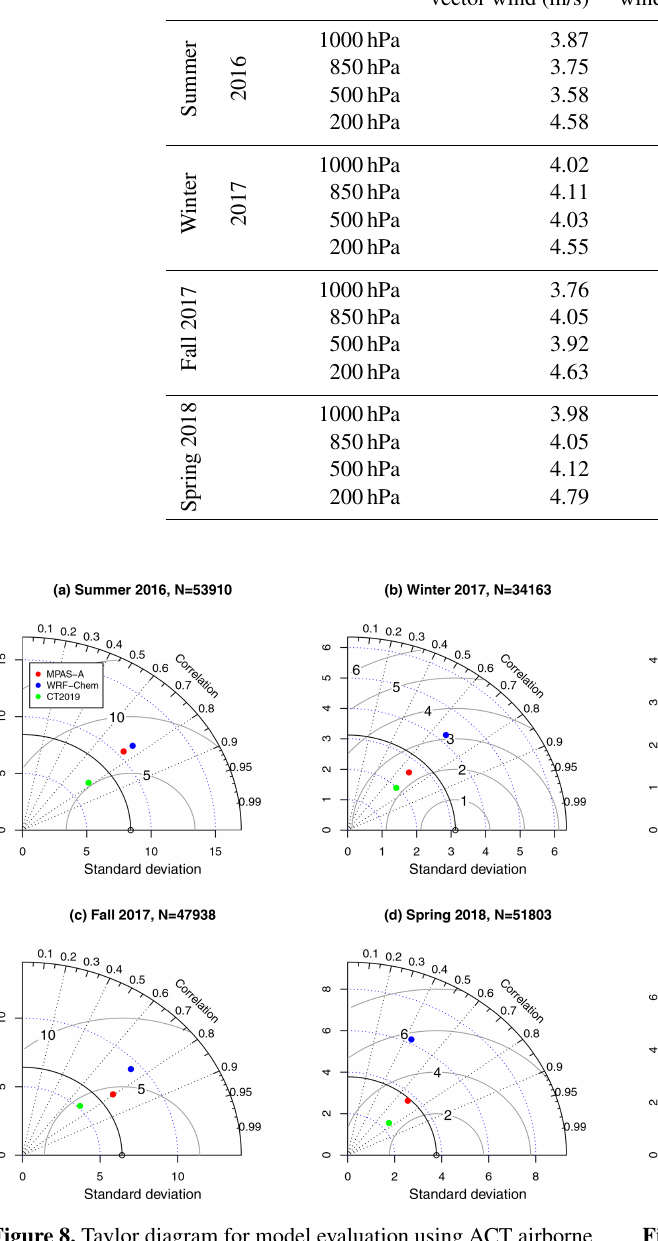
Figure 8. Taylor diagram for model evaluation using ACT airborne measurements in the boundary layer.